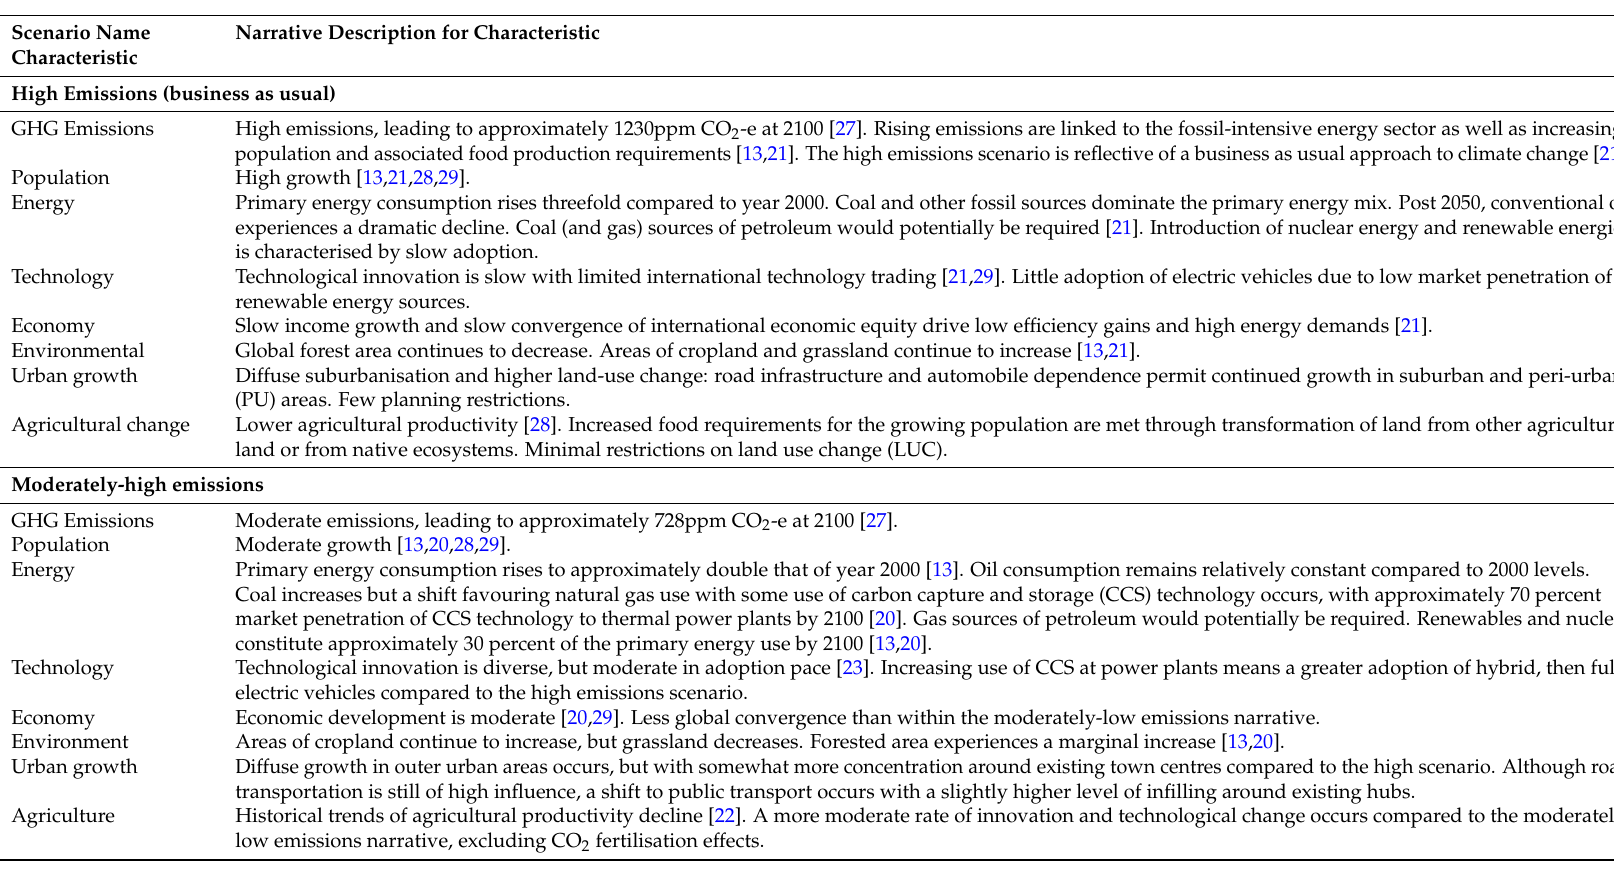
Table 1. Narratives for the four future urban development scenarios: high emissions; moderately-high emissions; moderately-low emissions; and low